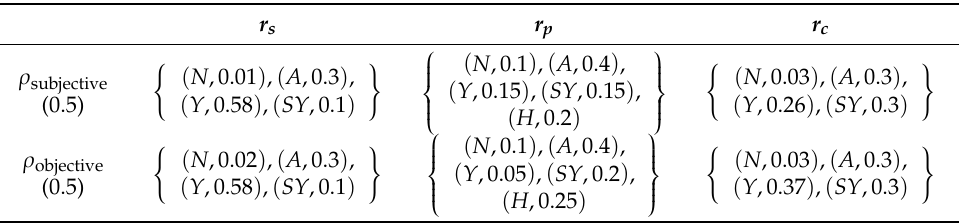
Table 5. Belief distribution of the subjective and objective weights.